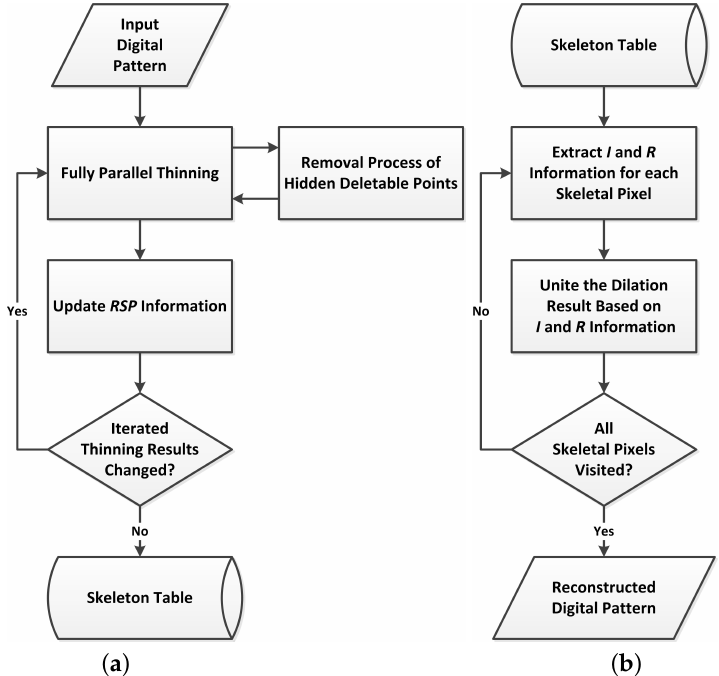
Figure 2. Flowchart of the proposed approach for digital pattern ( a ) thinning and ( b )